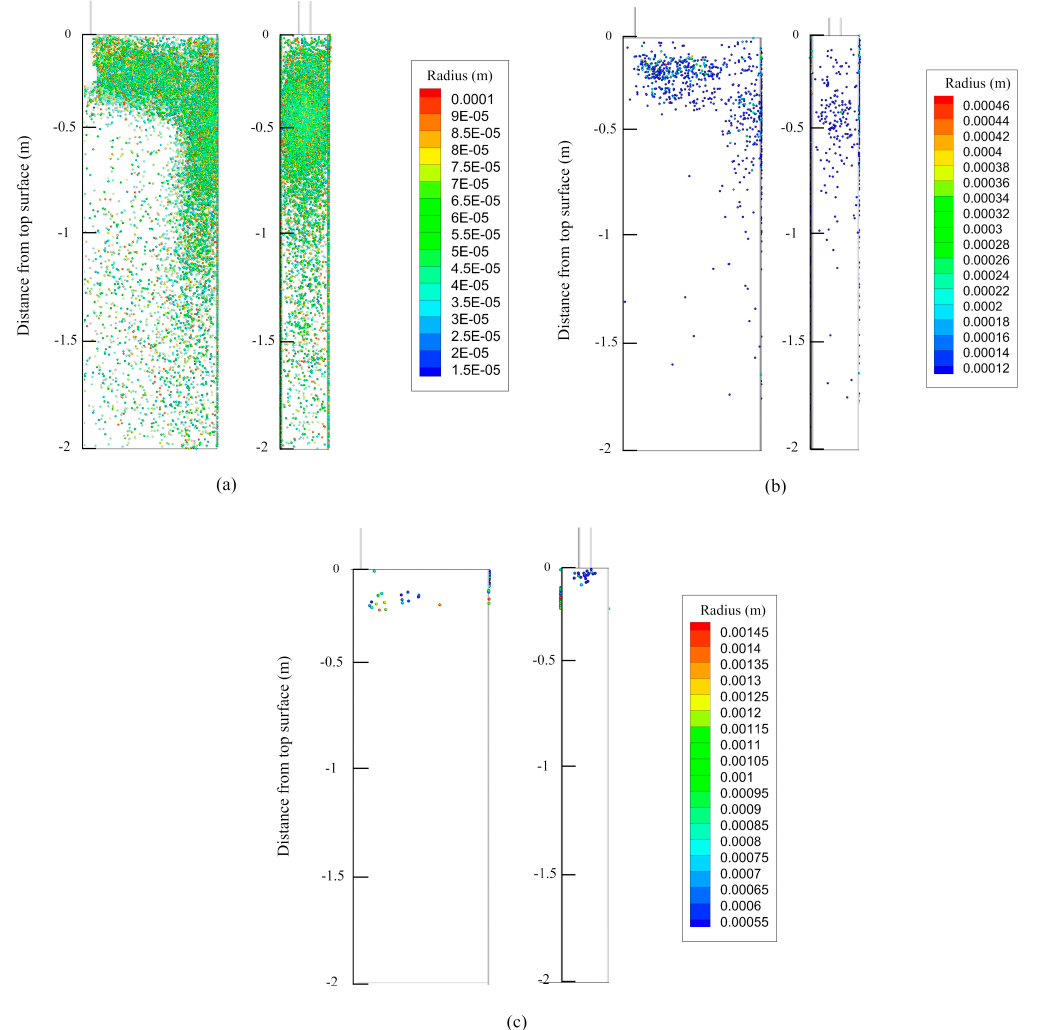
Figure 7. Locations of bubbles captured by the solidification shell. ( a ) Small bubble; ( b ) medium-size bubble and ( c ) large bubble.